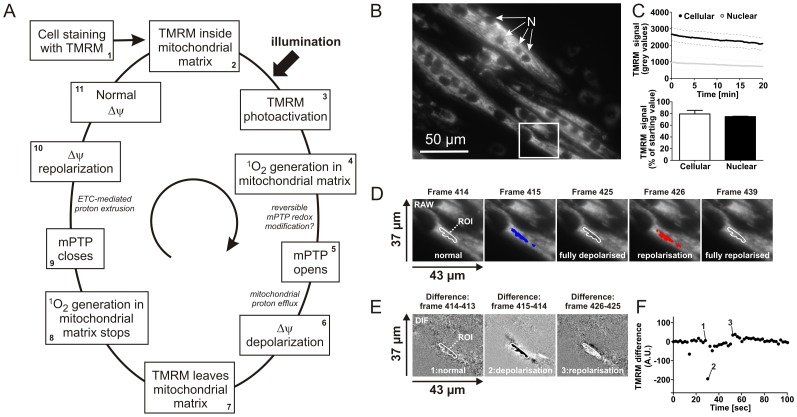
Photo-induction of ΔΨ flickering in TMRM-stained primary mouse myotubes.(A) Proposed mechanism underlying ΔΨ flickering in TMRM-stained cells [28]. Following TMRM staining (#1) and its accumulation in the mitochondrial matrix (#2) cells are illuminated leading to photo-induced generation of singlet oxygen (1O2) within the mitochondrial matrix (#4). As a consequence opening of the mPTP is stimulated (#5) leading to ΔΨ depolarization (#6) and TMRM efflux from the mitochondrial matrix (#7). The latter prevents photo-induced 1O2 generation in the matrix (#8), resulting in mPTP closure (#9), ΔΨ repolarization mediated by action of the mitochondrial electron transport chain (ETC; #10) and subsequent ΔΨ normalization (#11) after which the next depolarization/repolarization cycle can start. (B) Typical example of TMRM-stained myotubes. Nuclei are marked by ‘N’. The region of interest (ROI) depicted in panel D is indicated by a rectangle. (C) Upper panel: Time dependence of the average cellular and nuclear TMRM fluorescence intensity (N = 5 myotubes) during 20 min of recording. Lower panel: average cellular and nuclear TMRM fluorescence intensity after 20 min of recording (N = 5 myotubes). (D) Typical time-frames illustrating the localized disappearance (pixels colored blue by thresholding) and reappearance (pixels colored red by thresholding) of TMRM fluorescence intensity. (E) Difference (DIF) images calculated from the recorded images (see results for details) depicting cellular regions displaying ΔΨ depolarization (black pixels) and ΔΨ repolarization (white pixels). (F) Time dependent signal changes in the DIF images for the ROI marked in the first image. Numerals correspond to the images in panel E.